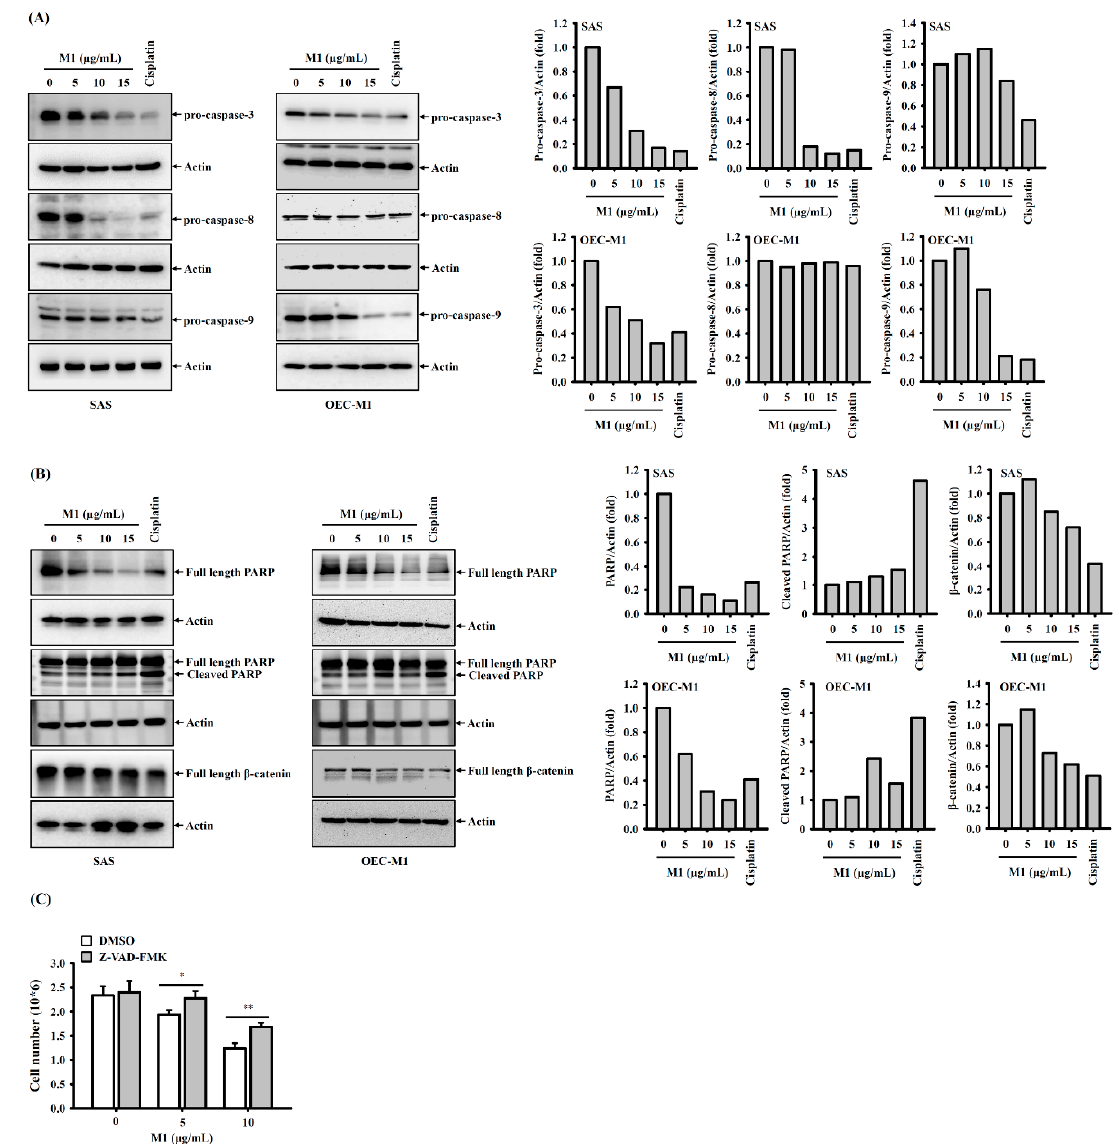
Figure 4. Ginsenoside M1 induced caspase-dependent cell death. ( A , B ) SAS cells and OEC-M1 cells were incubated for 24 h with ginsenoside M1, 50 µM cisplatin, or vehicle. The expression levels of caspase 3, caspase-8, caspase-9 ( A ), PARP and β -catenin ( B ) were analyzed by Western blotting. ( C ) SAS cells were incubated for 0.5 h with 20 µM Z-VAD-FMK followed by incubation for 24 h with ginsenoside M1 or vehicle. The cell numbers were counted by Trypan blue exclusion method. The data were expressed as mean ± SD; n = 3. * and ** indicate a significant difference at the level of p < 0.05 and p < 0.01, respectively. (Two-tailed t -test).